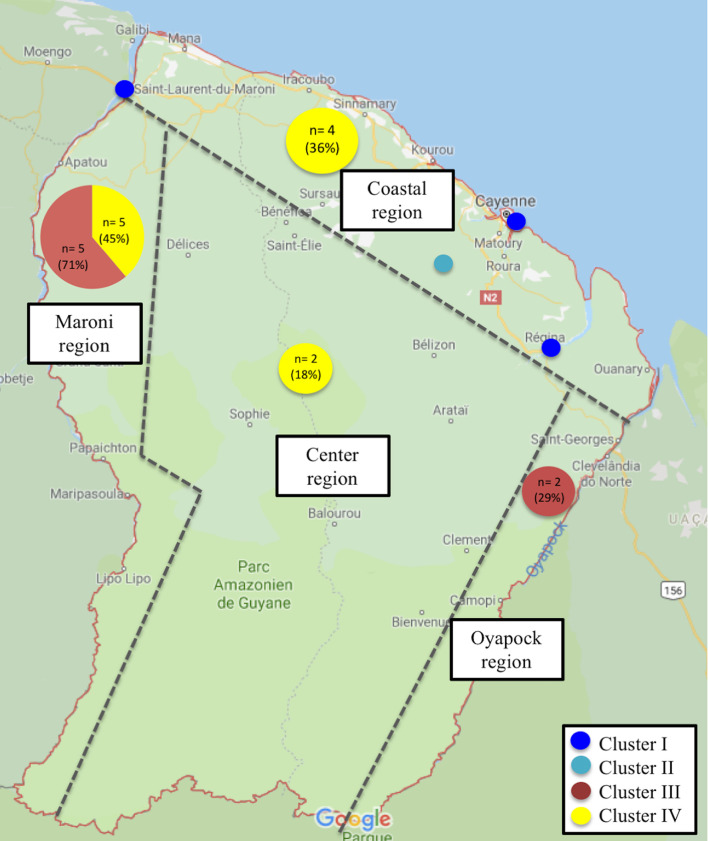
Molecular HSP70 (A) and cyt b (B) partial nucleotide sequence analysis by Maximum Likelihood method The evolutionary history was inferred by using the Maximum Likelihood method based on the Tamura-Nei model [35]. The tree with the highest log likelihood (-3176.92) is shown. The percentage of trees in which the associated taxa clustered together is shown next to the branches. Initial tree(s) for the heuristic search were obtained automatically by applying Neighbor-Join and BioNJ algorithms to a matrix of pairwise distances estimated using the Maximum Composite Likelihood (MCL) approach, and then selecting the topology with superior log likelihood value. The tree is drawn to scale, with branch lengths measured in the number of substitutions per site. The analysis involved 42 nucleotide sequences. Codon positions included were 1st+2nd+3rd+Noncoding. All positions containing gaps and missing data were eliminated. There were a total of 1242 positions in the final dataset. Evolutionary analyses were conducted in MEGA7 [36]. Dark blue shading represents patients from cluster I; Light blue shading represents patients from cluster II. Red shading indicates patients from cluster III and yellow shading indicates patients from cluster IV.